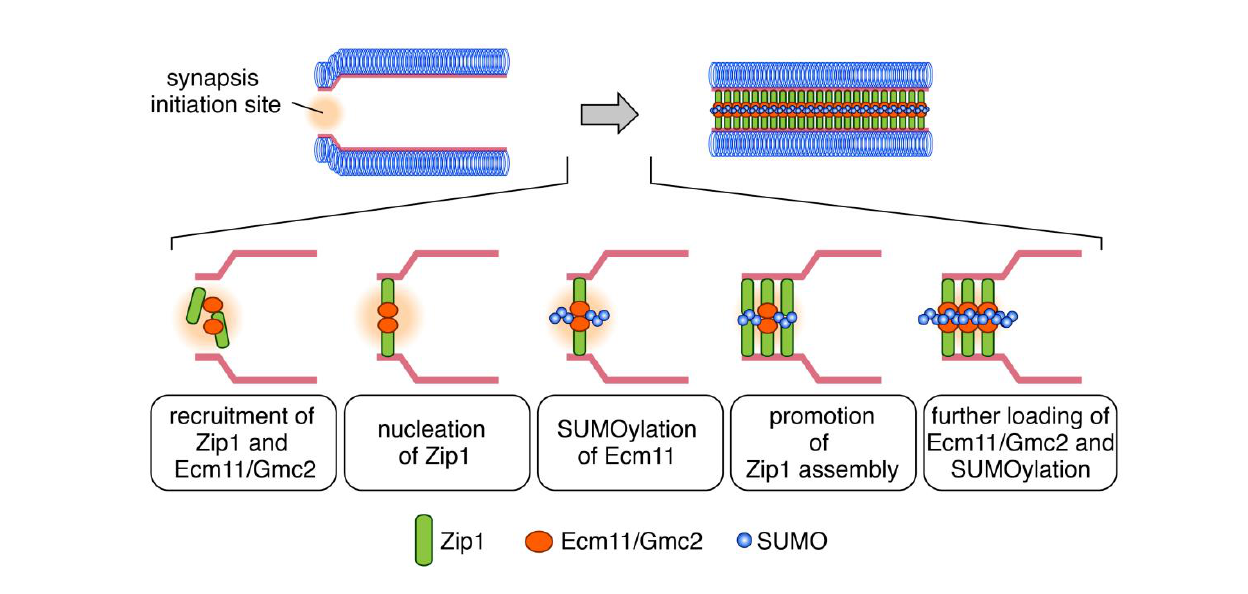
FIGURE 1: Mutual activation between Ecm11 SUMOylation and transverse filament assembly shapes the synaptonemal complex. We pro- pose the following model regarding the mechanism forming the synaptonemal complex (SC). First, the transverse filament protein (Zip1) and the assembly activation factor (Ecm11/Gmc2) are independently recruited to a synapsis initiation site. Recruited Zip1 starts to assemble in conjugation with Ecm11/Gmc2, which promotes SUMOylation of Ecm11. This ignites the positive feedback loop, leading to further assembly of Zip1, loading of Ecm11/Gmc2 and SUMOylation of Ecm11 until the SC is fully